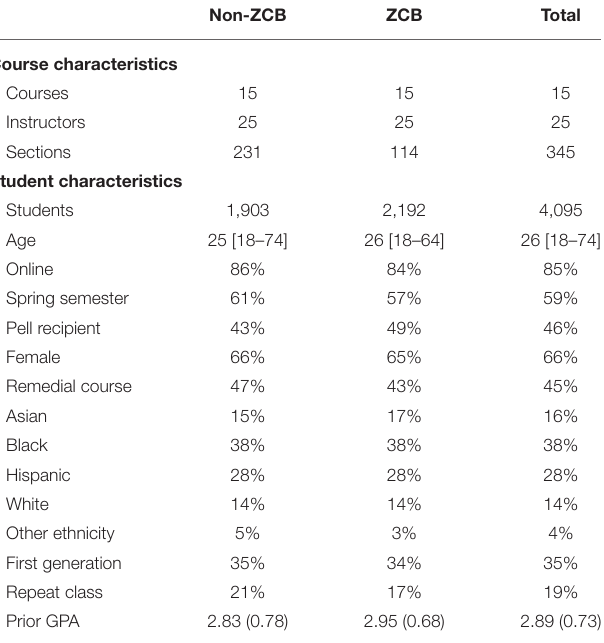
TABLE 1 | Summary of analytic